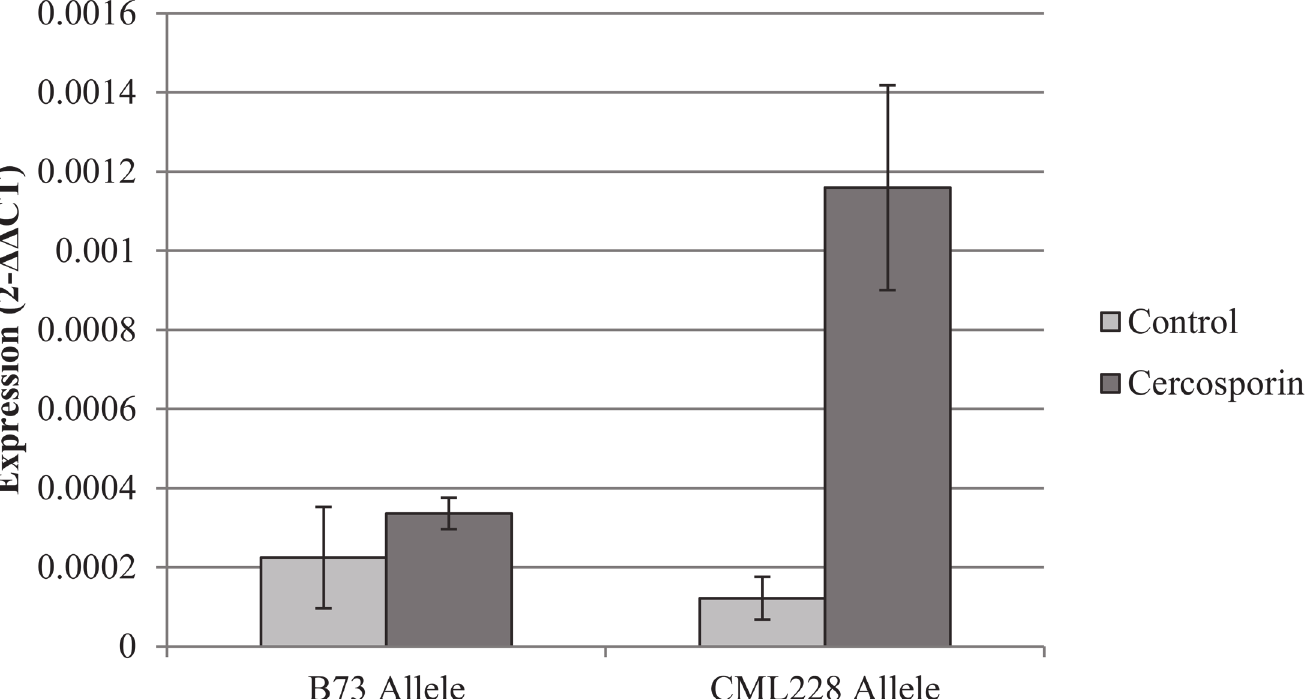
Fig 5. Analysis of flavin-monooxygenase expression at qGLS1.04. Expression differences were detected for the putative flavin-monooxygenase among heterogeneous inbred family lines segregating at qGLS1.04 for the B73 or CML228 maize alleles. The heterogenous inbred family lines were treated with cercosporin or the acetone control on either side of the maize leaf midrib. There was a significant difference between the CML228 samples treated with cercosporin and the other samples in the experiment ( p =